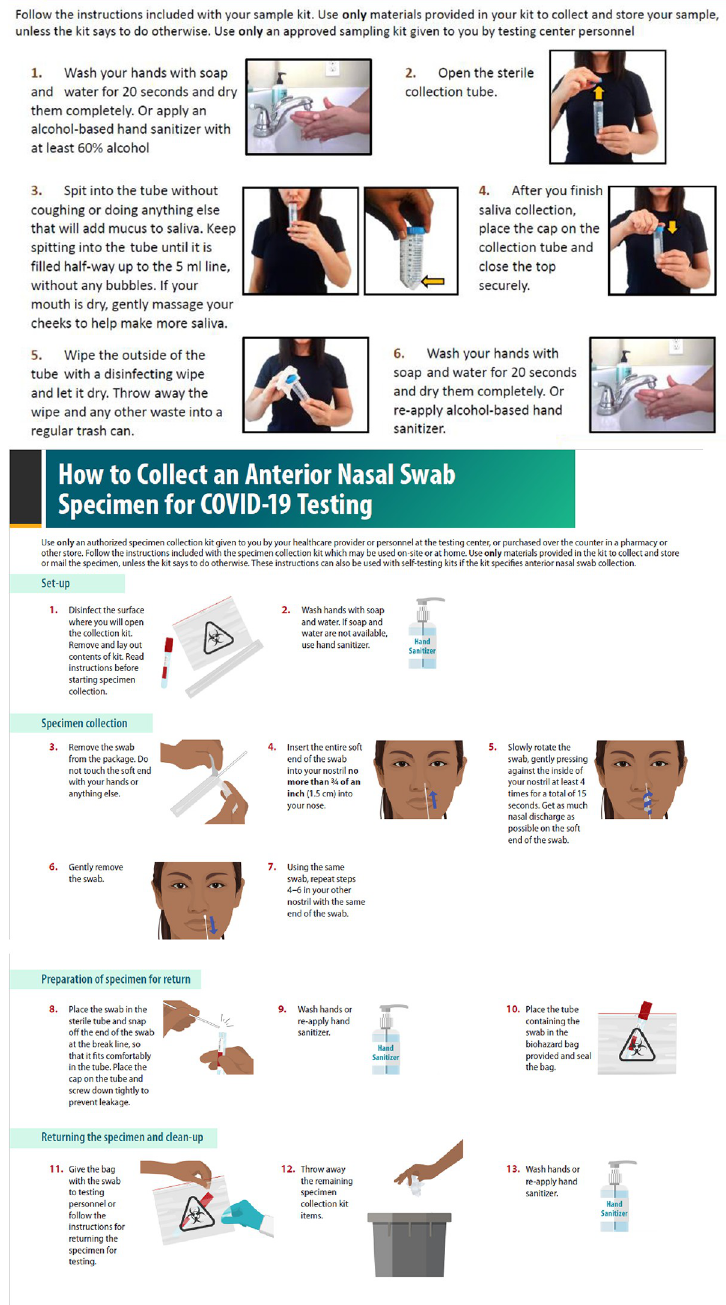
Fig 1. Saliva (A) and anterior nasal swab (B) self-collection instructional sheet handed to participants at Grady Memorial Hospital—Atlanta, GA, August–November 2020.